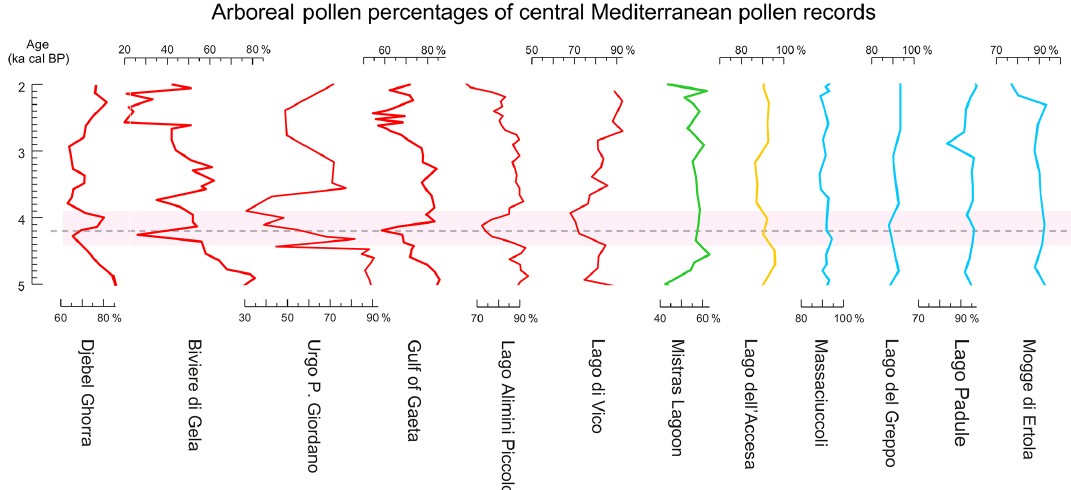
Figure 2. Arboreal pollen (AP) percentage diagrams of selected sites from the central Mediterranean. The dashed line and pink band represent the 4.2ka event. The following pollen records have been redrawn from the original publications: Biviere di Gela: Noti et al. (2009); Urgo Pietra Giordano: Tinner et al. (2016); Lago dell’Accesa: Drescher-Schenider et al. (2007); Lago di Massaciuccoli: Colombaroli et al. (2007); Lago del Greppo: Vescovi et al. (2010b); Lago Padule: Watson (1996); Mogge di Ertola: Guido et al. (2013). The record of Djebel Ghorra (Ben Tiba, 1995) was redrawn from Stambouli-Essassi et al. (2007). The records from the Gulf of Gaeta (Di Rita et al., 2018b), Lago Alimini Piccolo (Di Rita and Magri, 2009), Lago di Vico (Magri and Sadori, 1999), and Mistras Lagoon (Di Rita and Melis, 2013) were analyzed by the